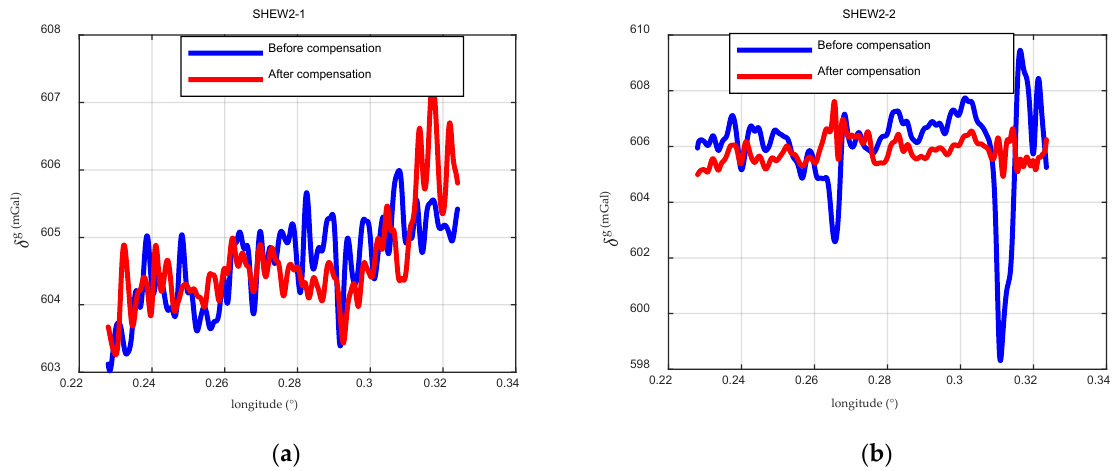
Figure 5. Gravity-measurement result curves for survey line SHEW2 before and after compensation (300 s filtering). ( a ) Gravity-measurement results for survey line SHEW2-1 before and after compen- sation; ( b ) gravity-measurement results for survey line SHEW2-2 before and after compensation.